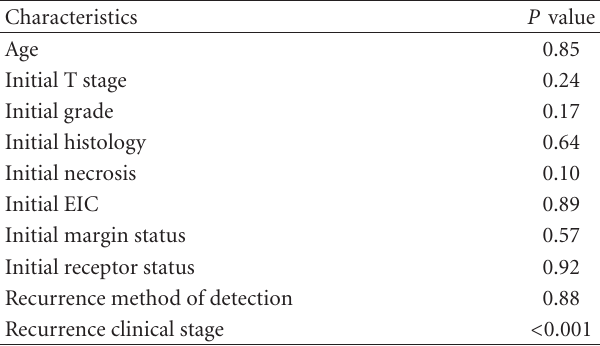
Table 4: Predictors of pathologic T1 size of recurrence from multivariate